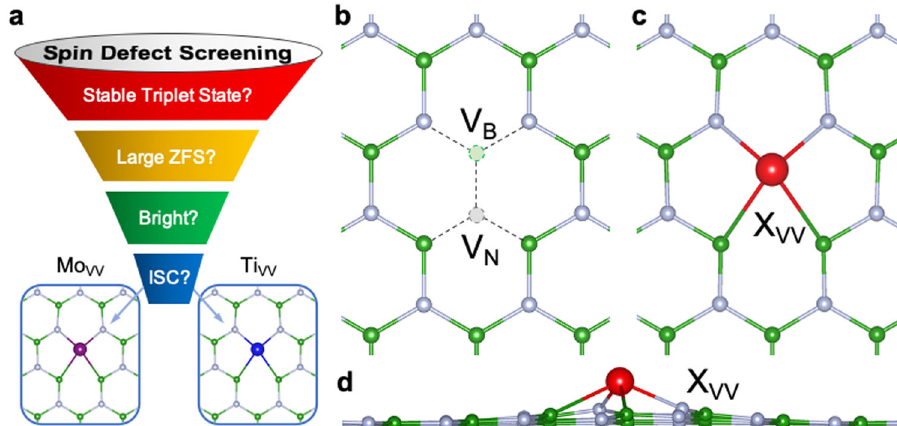
Fig. 1 Screening of spin defects in h -BN. a Schematic of the screening criteria and work fl ow developed in this work, where we fi rst search for defects with stable triplet ground state, followed by large zero- fi eld splitting (ZFS), then "bright'' optical transitions between defect states required for SPEs or qubit operation by photon, and at the end large intersystem crossing rate (ISC) critical for pure spin state initialization. b Divacancy site in h -BN corresponding to adjacent B and N vacancies (denoted by V B and V N ). c Top-view and d side-view of a typical doping con fi guration when placed at the divacancy site, denoted by X VV . Atoms are distinguished by color: gray = N, green = B, purple = Mo, blue = Ti, red = X (a generic